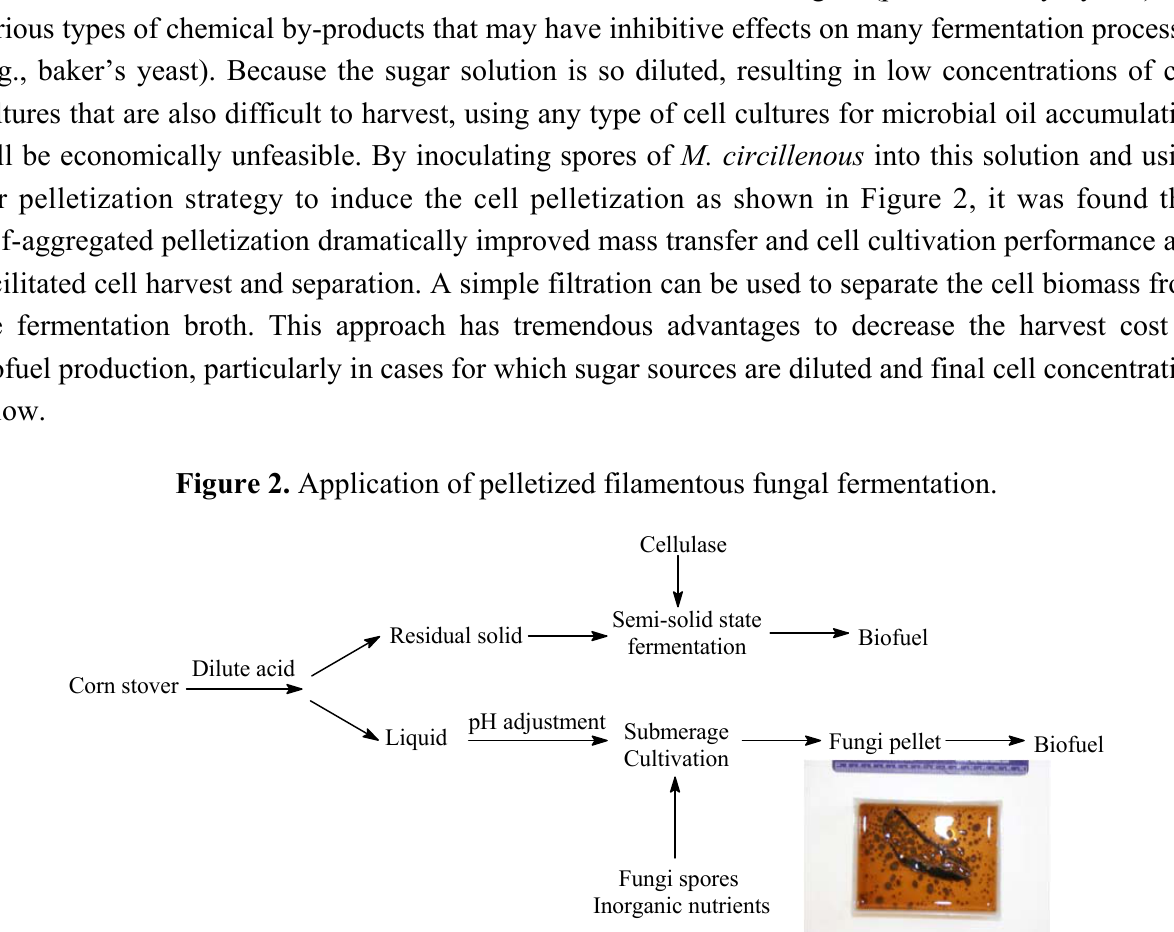
; and ( b ) by only 3